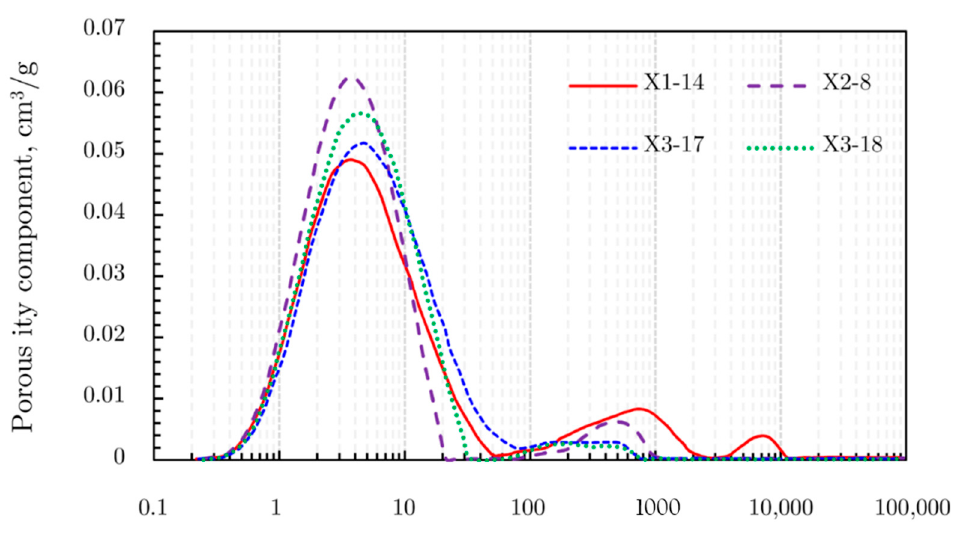
Figure 13. PSD of samples from the Longmaxi Formation based on NMR.